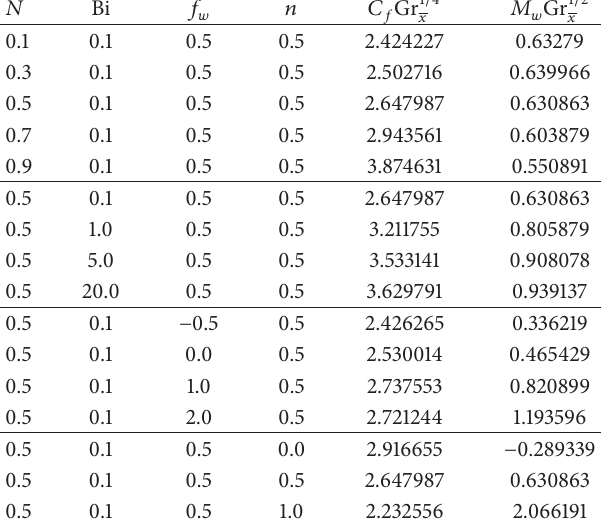
Table 3: Effects of skin friction and wall couple stress for varying values of Biot numbers Bi, micropolar parameter 𝑁 , material parameter 𝑛 , and suction/injection parameter 𝑓 𝑤